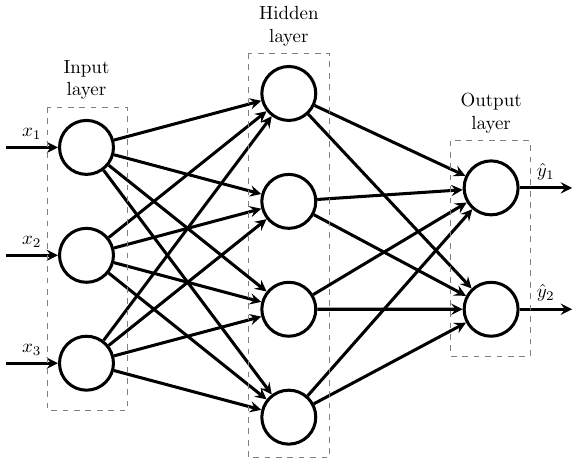
Figure 5. Graph of a feedforward neural network with one hidden